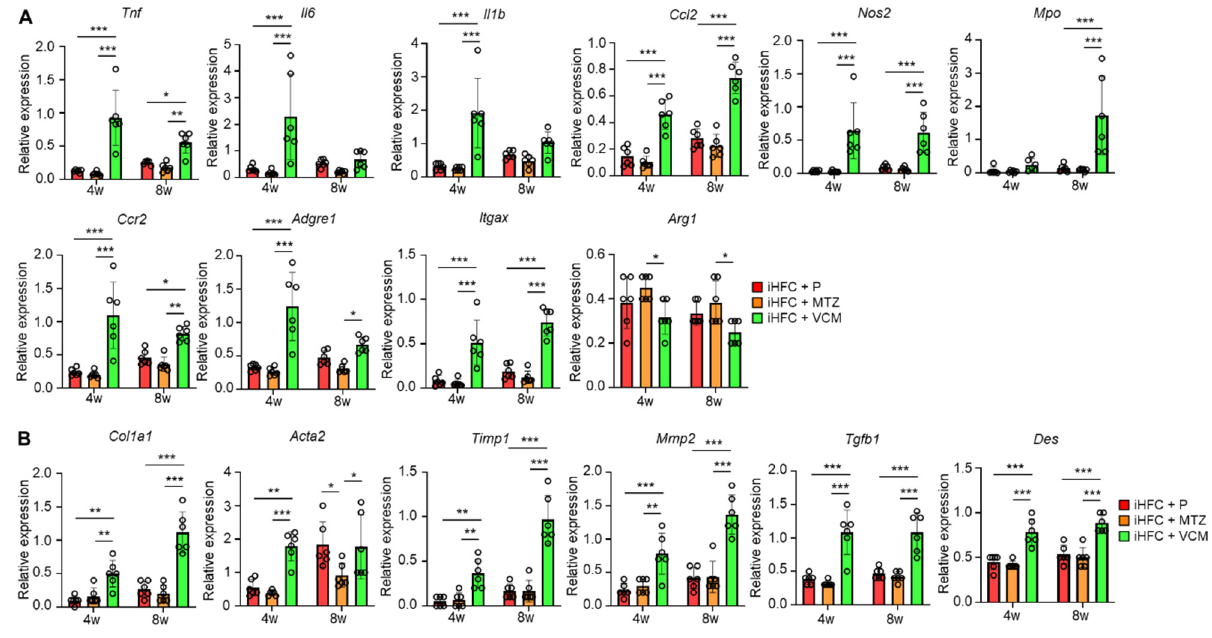
Figure 3. VCM treatment increases the levels of inflammation- or fibrosis-related gene expression in the liver of iHFC diet-fed TSNO mice. ( A ) RT-qPCR of TNF- α ( Tnf ), IL-6 ( Il6 ), IL-1b ( Il1b ), CCL2 ( Ccl2 ), iNOS ( Nos2 ), MPO ( Mpo ), CCR2 ( Ccr2 ), F4/80 ( Adgre1 ), CD11c ( Itgax ), and Arg-1 ( Arg1 ) mRNA in the livers of placebo- or antibiotic-treated TSNO mice fed the iHFC diet (n = 6 per group). ( B ) RT-qPCR of collagen type 1 ( Col1a1 ), α SMA ( Acta2 ), TIMP-1 ( Timp1 ), MMP2 ( Mmp2 ), TGF- β ( Tgfb1 ), and Desmin ( Des ) mRNA in the livers of TSNO mice fed the iHFC diet (n = 6 per group). Data are shown as means ± SD. * p < 0.05, ** p < 0.01, *** p < 0.001.